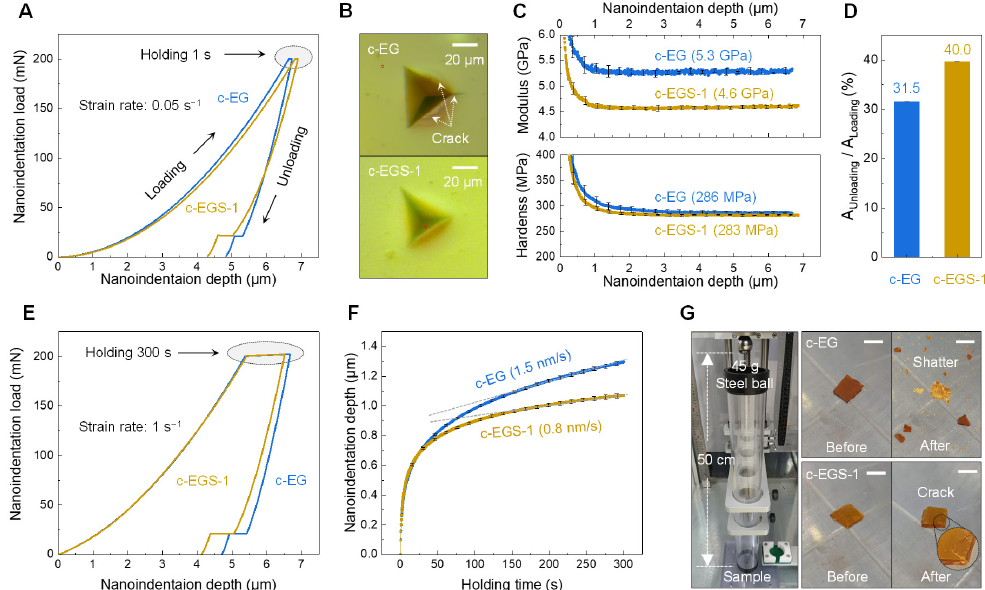
Figure 5. Mechanical characterization. ( A ) Representative nanoindentation load-depth curves with strain rate of 0.05 s − 1 and 1 s holding at the maximum load. ( B ) Optical microscopy images exhibiting residual impression after the nanoindentation tests ( A ). ( C ) Nanoindentation modulus (top) and hardness (bottom) to depth curves of c-EG and c-EGS-1. Elastic modulus and hardness values were obtained at the nanoindentation depth of 5 μ m. All data are presented as mean ± SD, N = 5. ( D ) Area ratio of unloading to loading curve in nanoindentation tests ( A ); mean ± SD, N = 5. ( E ) Representative nanoindentation load-depth curves with strain rate of 1 s − 1 and 300 s holding at the maximum load. ( F ) Nanoindentation depth–time curves during the holding segments in the tests ( E ) for creep analysis. The gray dashed lines were used to show the slope of the creep rate of c-EG and c-EGS-1 in the steady-state creep region; mean ± SD, N = 5 ( G ) Photographs showing c-EG (top) and c-EGS-1 (bottom) before and after ball drop test (left); scale bar, 0.5 cm.